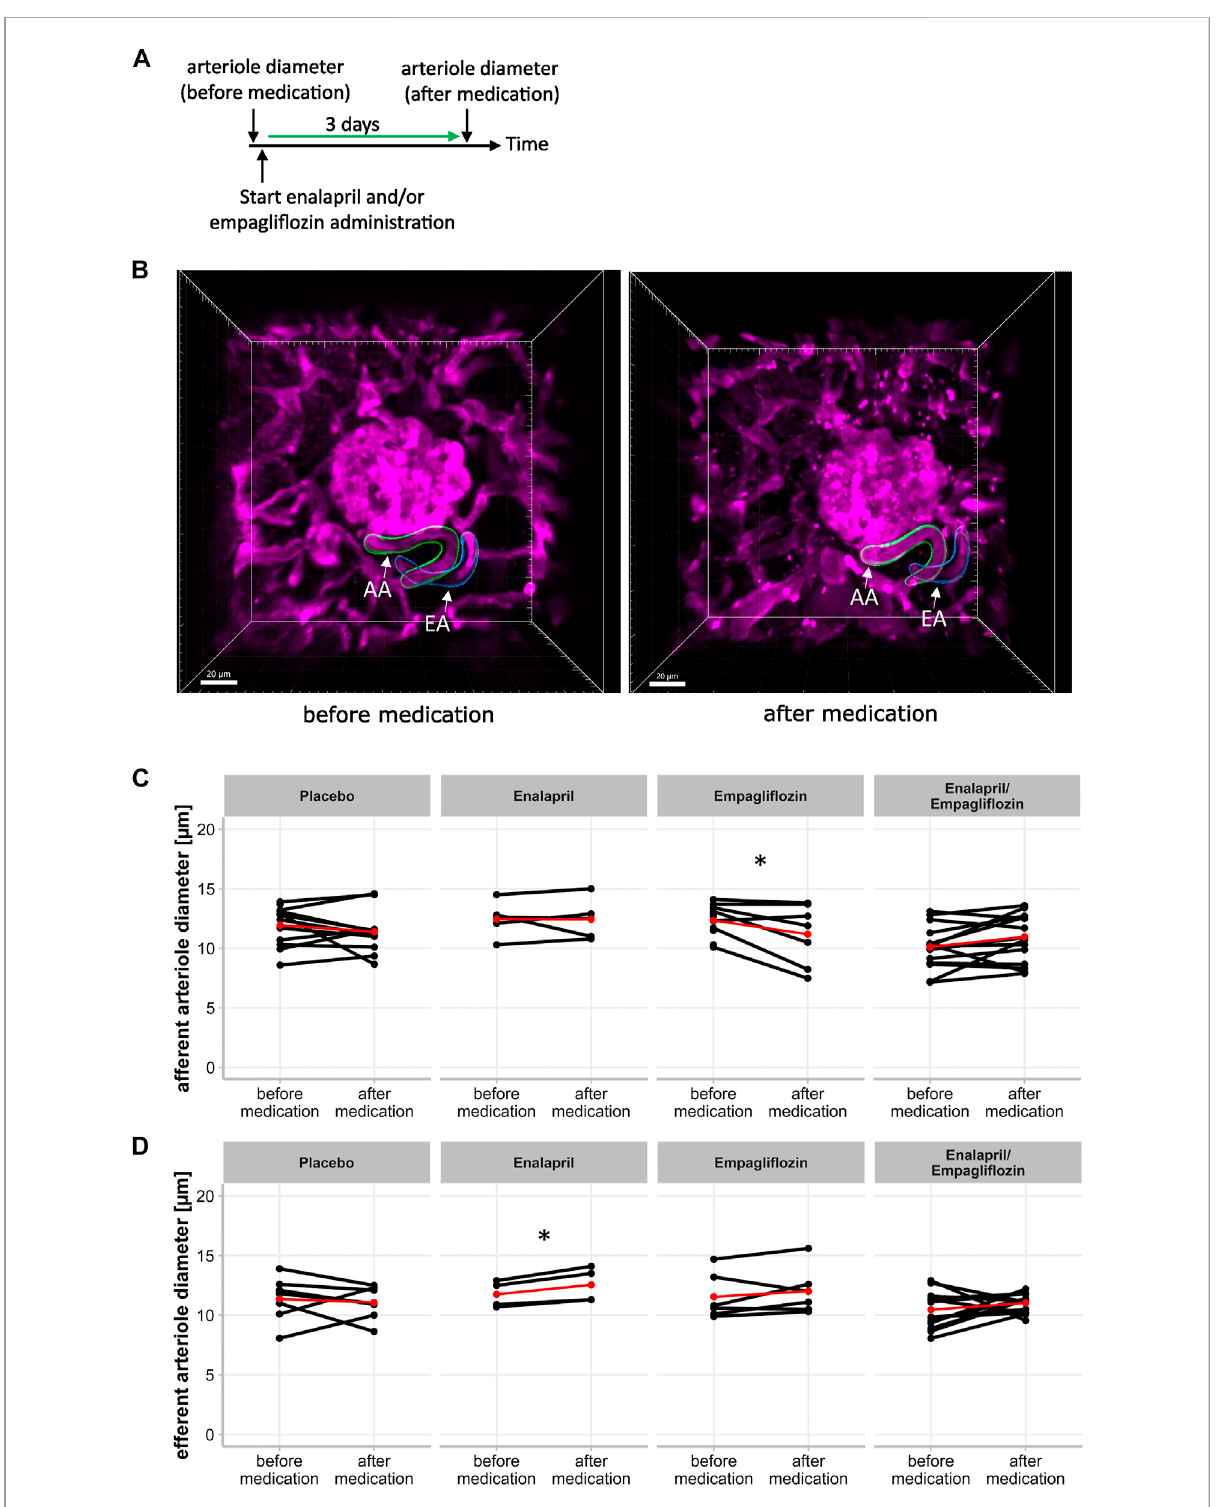
FIGURE 3 Effect of enalapril, empagli fl ozin and enalapril/empagli fl ozin on afferent and efferent arteriole alterations in STZ-diabetic mice. (A) Timeline of experimetal setup for afferent and efferent arteriole diameter measurement. First measurement (before medication) of arteriole diameter